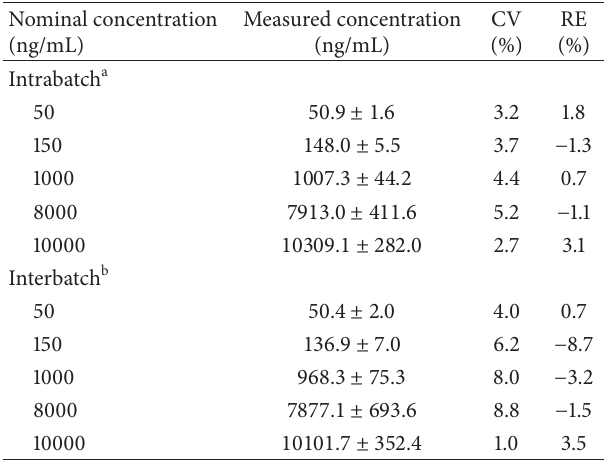
Table 2: Intrabatch and interbatch precision and accuracy of PD in rat plasma.